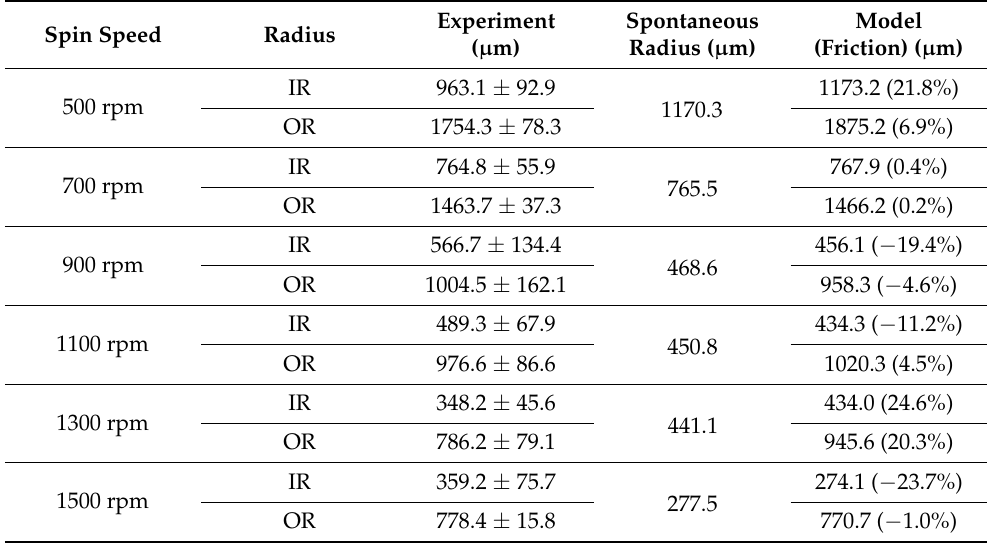
Table 2. Comparison of the inner and outer radii, experimentally analyzed, and their model prediction in terms of spontaneous radius, as well as in the presence of the friction assumption by varying the spin speed from 500 rpm to 1500 rpm, thus the bilayer thickness. IR = inner radius; OR = outer radius. N =